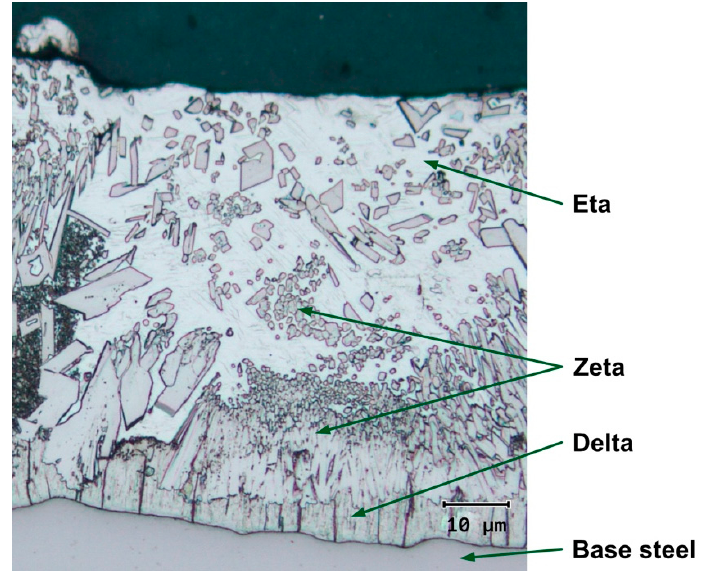
Figure 1. Photomicrograph of a typical hot-dip galvanized steel coating: intermetallic phases of iron (delta, zeta) and zinc (eta).